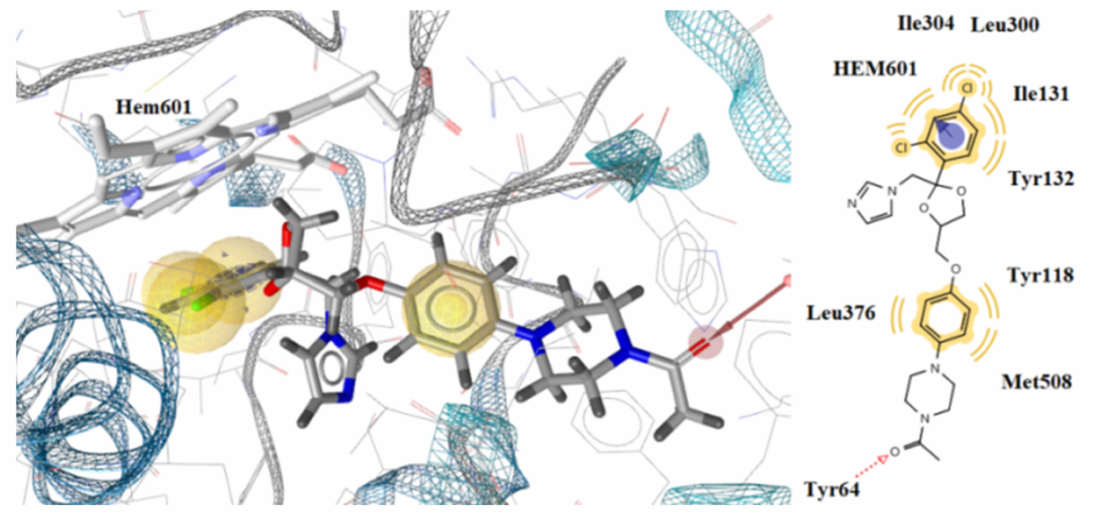
Figure 8. Docking of ketoconazole to CYP51 Ca receptor. Red and green dotted arrows indicate H-bond, blue arrows aromatic interactions and yellow spheres hydrophobic